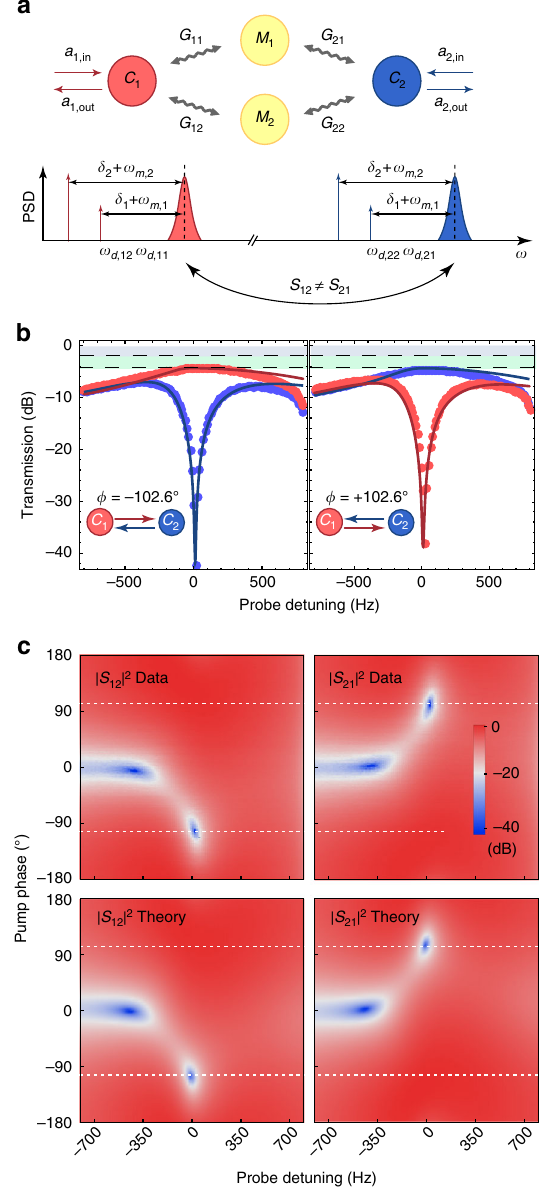
Fig. 2 Electromechanical isolator. a Mode coupling diagram for electromechanically induced nonreciprocity. Two microwave cavities ( C 1 and C M M 2 ) are coupled to two mechanical modes ( 1 and 2 ) with the electromechanical coupling rates G ij (where i , j = 1, 2), inducing two distinct signal conversion paths. Power spectral density (PSD) of the two microwave cavities and arrows indicating the frequency of the four microwave pump tones slightly detuned by δ i from the lower motional sidebands of the resonances. All four pumps are phase-locked while the signal tone is applied. Only one of the microwave source phases is varied to fi nd the optimal interference condition for directional transmission between ports 1 and 2. b Measured power transmission (dots) in forward | S 21 | 2 (cavity 1 → cavity 2) and backward directions | S 12 | 2 (cavity 2 → cavity 1) as a function of probe detuning for two different phases ϕ =± 102.6 º . The solid lines show the results of the coupled-mode theory model discussed in the text. Grey shaded areas denote cavity loss and green shaded areas insertion loss. c Experimental data and theoretical model of measured transmission coef fi cients | S 12 | 2 and | S | 2 as a function of signal detuning and pump phase ϕ . Dashed lines indicate 21 the line plots for the two phases ϕ =± 102.6 º as shown in